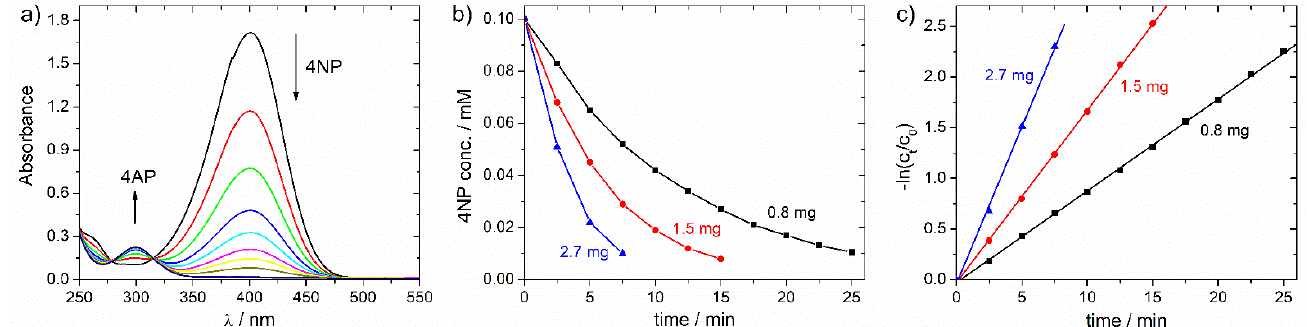
Figure 3. ( a ) Time dependent evolution of UV/vis spectra showing the decreasing amounts of 4NP anion in the Ni-NP/C catalyzed 4NP reduction reaction by NaBH 4 ; ( b ) concentration of 4NP versus time and ( c ) − ln(c t /c 0 ) versus time for the 4NP reduction reaction catalyzed by Ni-NP/C (amount of catalyst used is shown in Figures; initial 4NP and NaBH 4 concentrations are 0.1 and 10 mM, respectively).